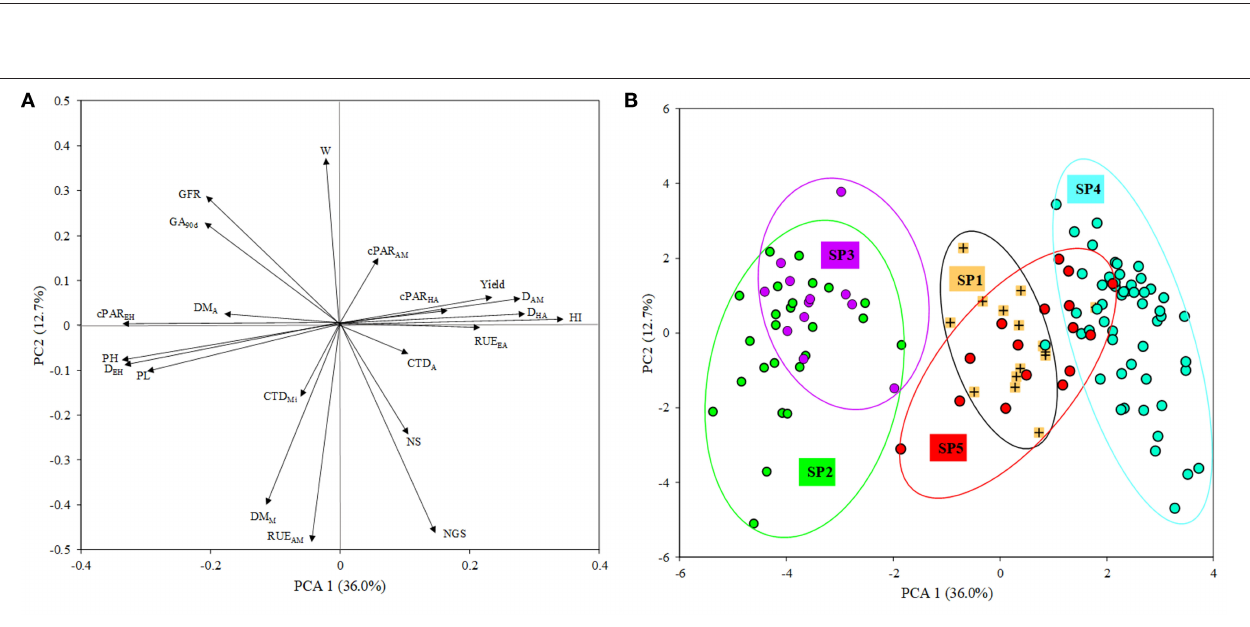
Frontiers in Plant Science |